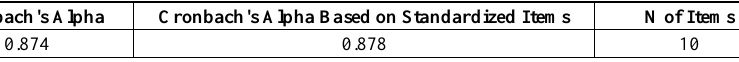
Table 3. Reliability of